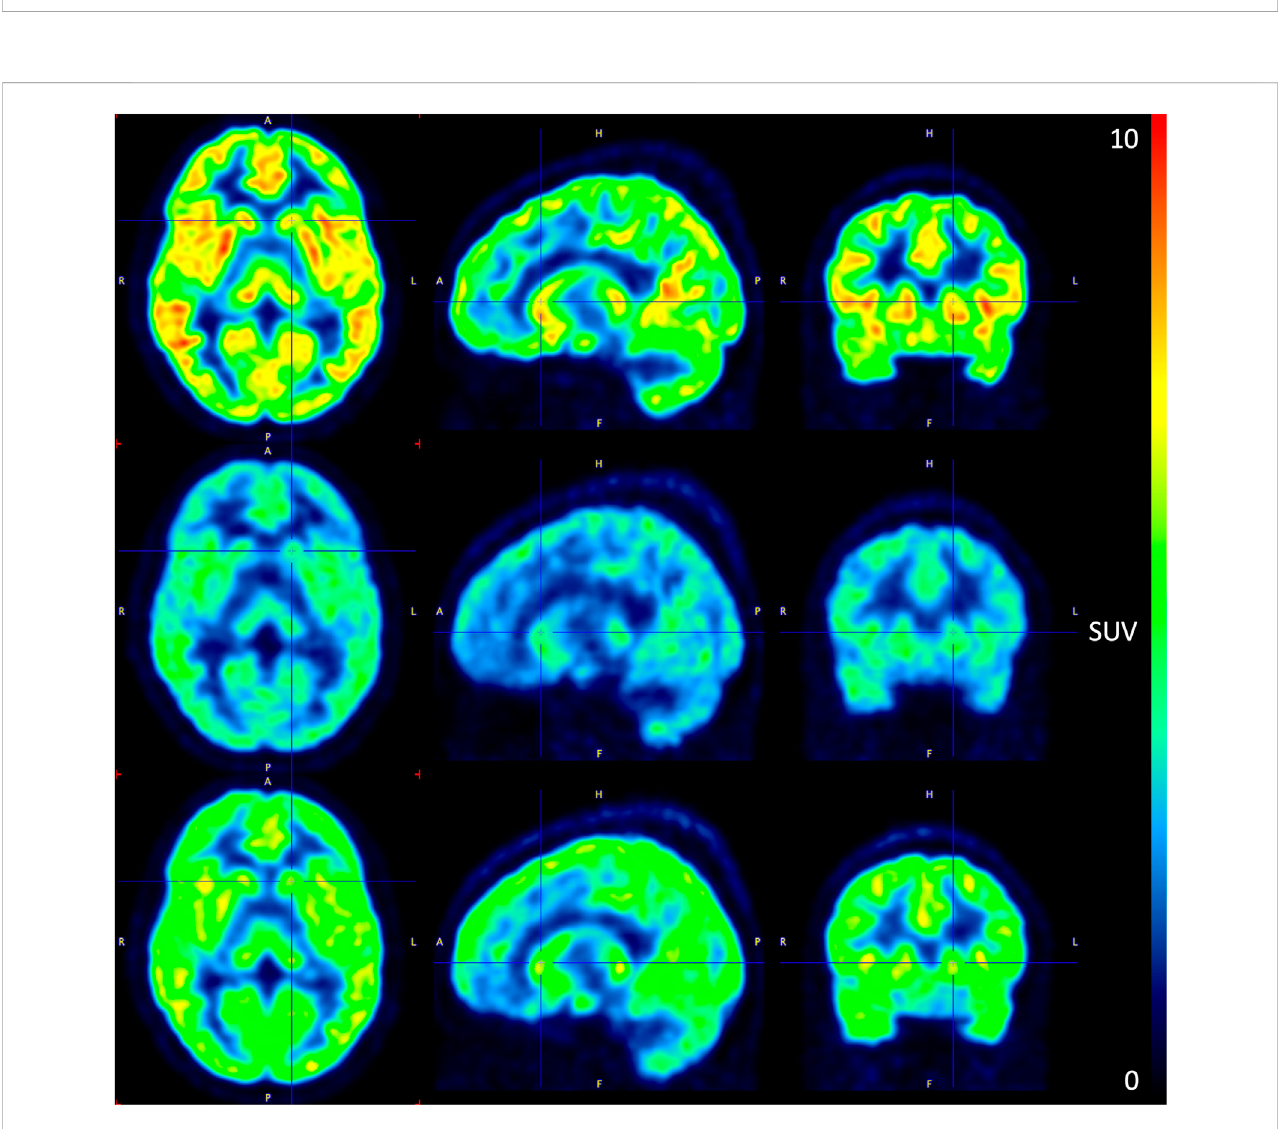
FIGURE 4 PET image of 11 C-UBC-J binding during the pre-dose (top), T max (mid), and 24 h post-dose (bottom) scan at the 10 mg SDI-118 dose level in a selected subject (left) axial plane (mid) sagittal plane (right) coronal plane. SUV: standardized uptake value.